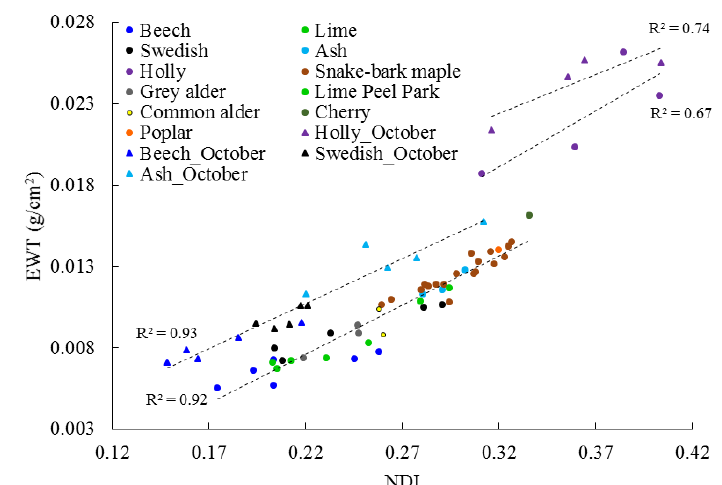
Figure 4. The NDI–EWT pooled model for the August dataset (bottom), after excluding holly leaf samples and adding leaf samples measured by Elsherif, et al. [38], and the NDI–EWT pooled model for the October dataset (top), after excluding holly leaf samples. Holly species-specific NDI–EWT models for August (bottom) and October (top).